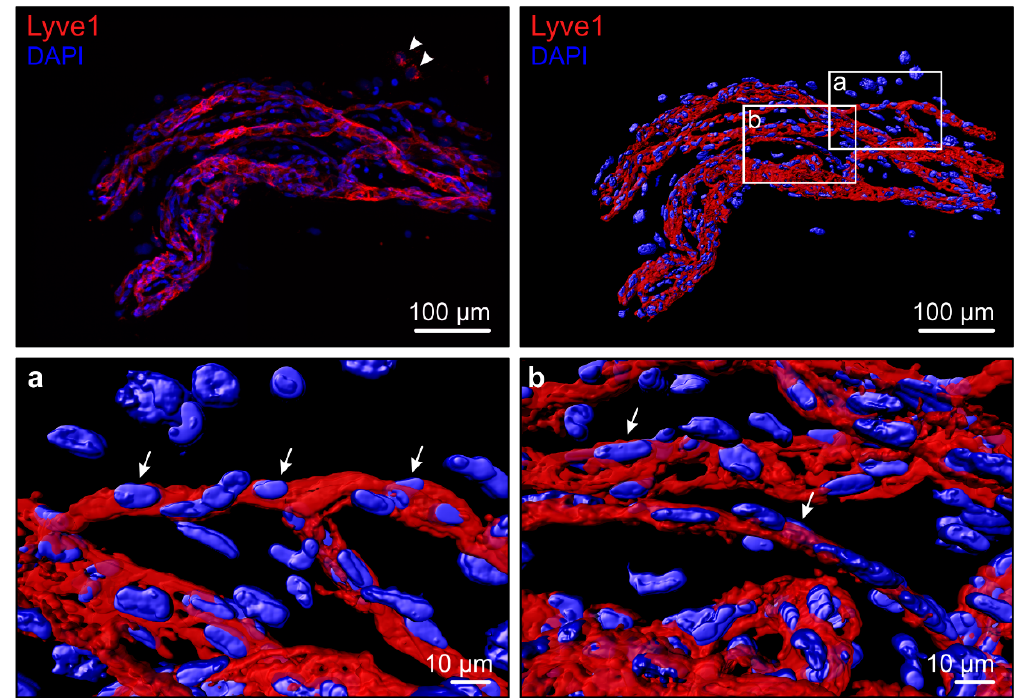
Figure 1. 3D volume reconstruction of a fresh PDR fibrovascular tissue shows lymphatic endothelium. The PDR fibrovascular tissue was stained by whole-mount immunofluorescence for Lyve1 (R&D Systems, Oxon, UK) (red). Hoechst-33342 (Thermo Fisher Scientific, Cheshire, UK) counterstain (blue) visualizes nuclei. Arrows indicate the Lyve1+ endothelial cell lining in the PDR neovasculature. Isolated Lyve1 + positive extravascular cells, possibly macrophages, are also present (arrowhead). The image was taken using Zeiss AxioImager.Z1 upright epifluorescence microscope with Apotome combined with a computer-controlled Hamamatsu Orca R2 1.3 megapixel monochrome CCD camera and ZEN software, using a 20 × Plan Apochromat, 0.8 NA objective (Zeiss, Jena, Germany). The captured Z-stack was imported into Imaris software (Imaris, version 9.1.0, Bitplane, Zurich, Switzerland) and processed by volume and surface reconstruction of the Lyve1 + endothelium and of the nuclei.